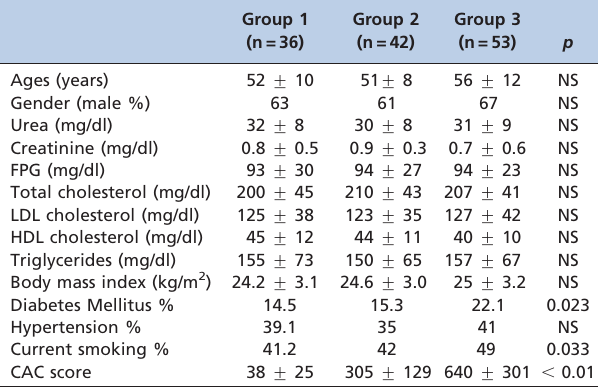
Table 1 - Baseline demographic and laboratory data characteristics.